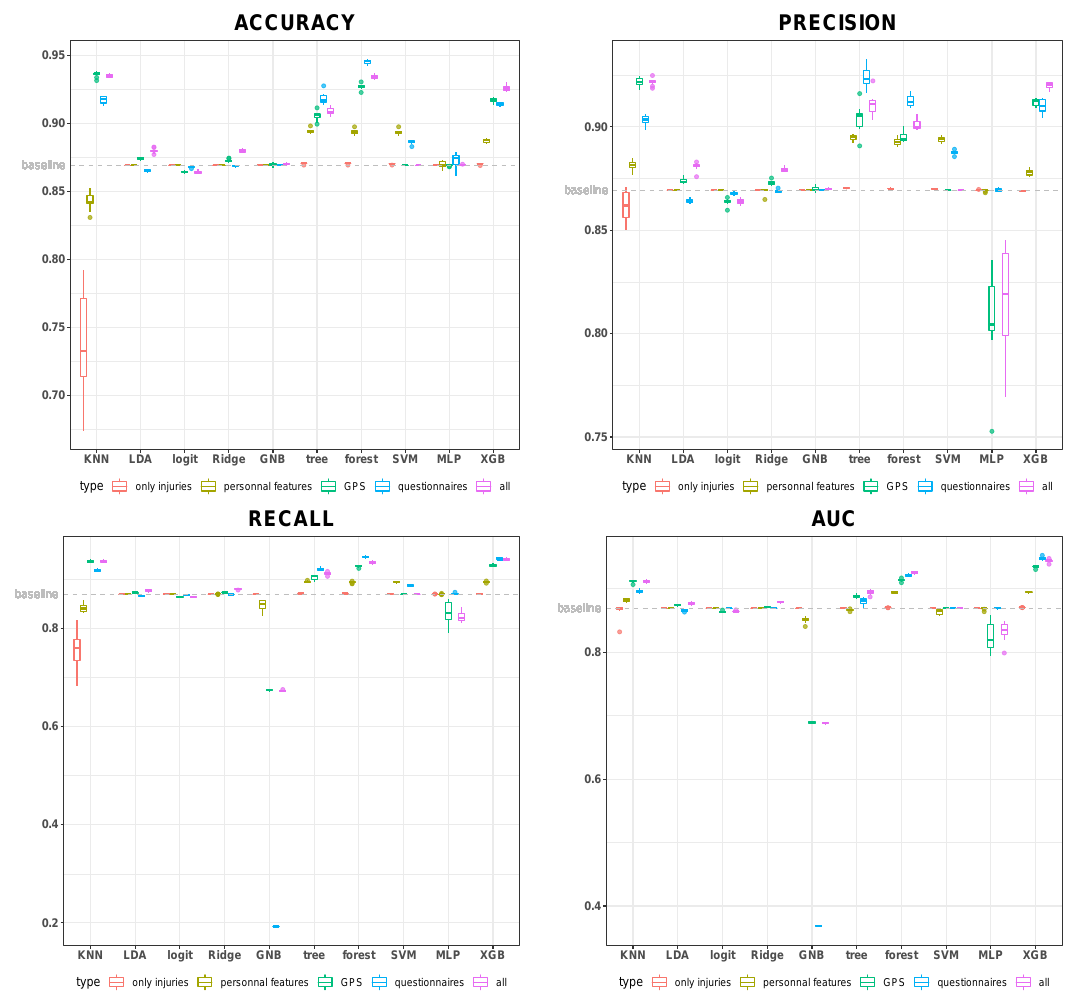
Figure 2. One-week predictive performance of ten machine learning methods according to five types (in color) of data sets. Predictive results are presented as box plots, in which the box indicates quartile values; the whiskers indicate the upper and lower values; circle indicates